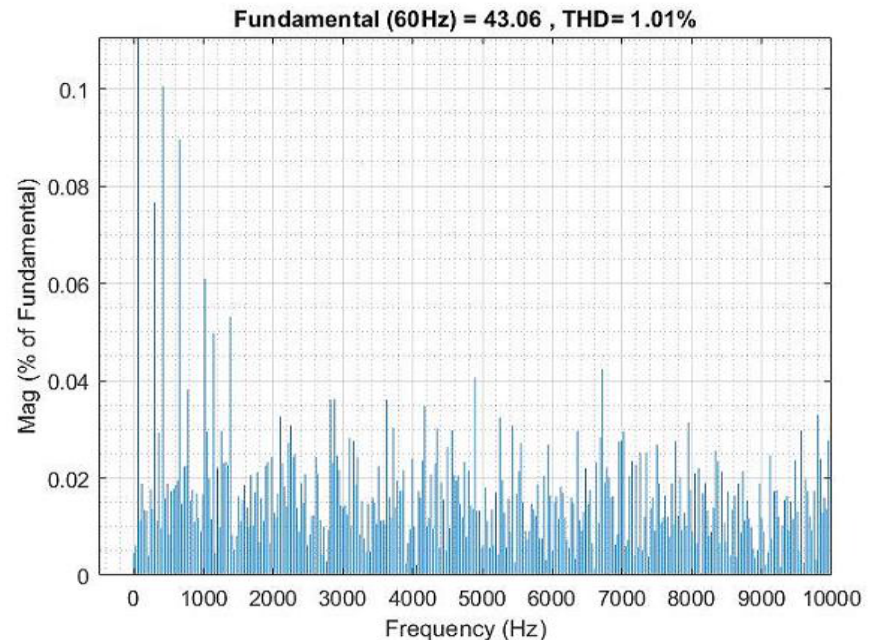
Figure 10. % THD of current for the modified two-step horizon prediction for a single DG connected in grid-connected mode.